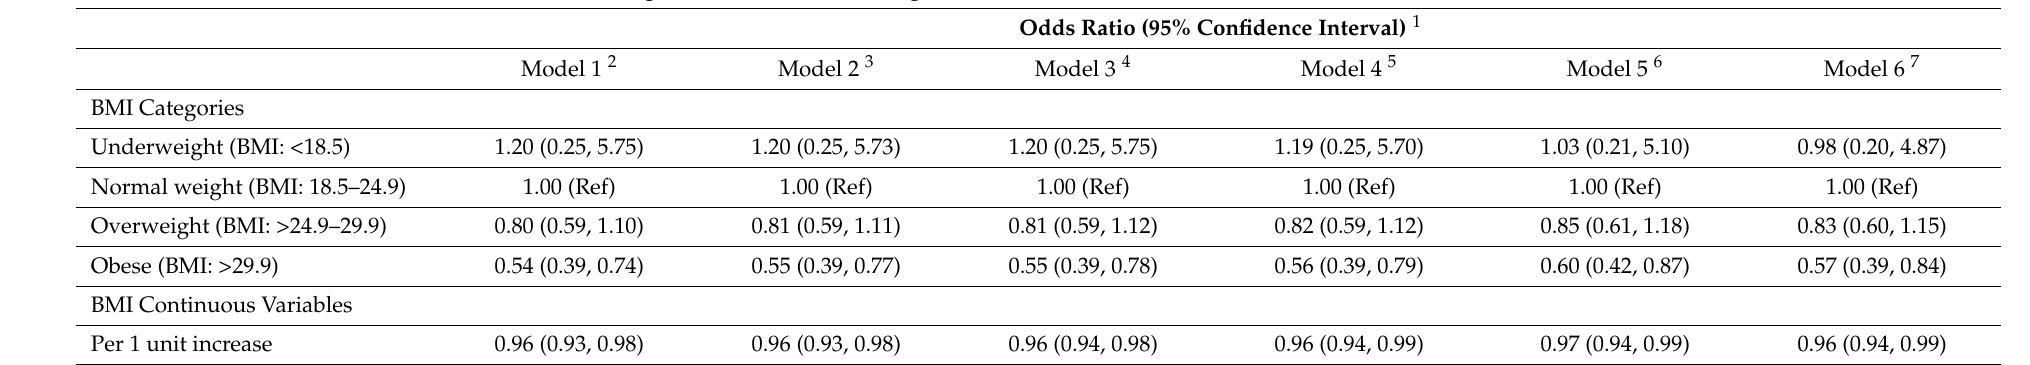
Table 4. Association of BMI and interval breast cancer (IBC) diagnosed within 1 year after last normal mammogram screening compared to screening-detected breast cancers (SBC) sensitivity